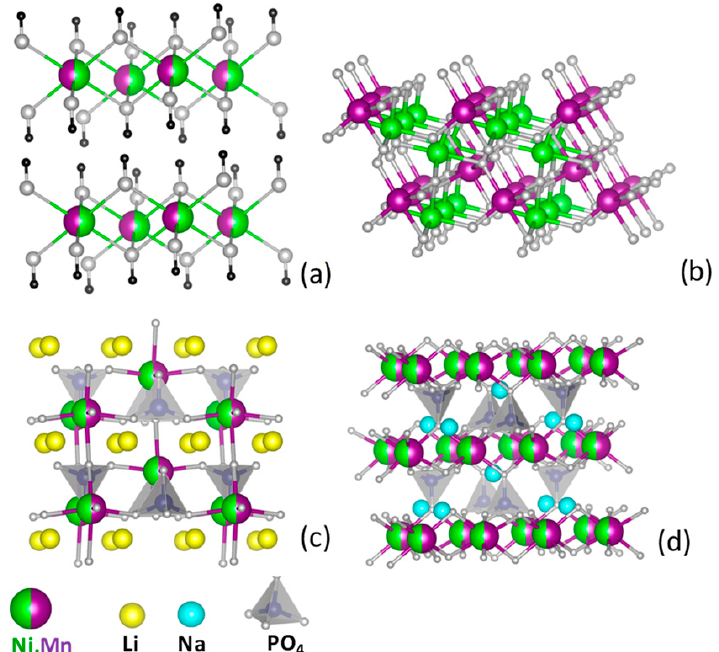
Figure 1. Schematic view of the crystal structures of mixed Ni–Mn phases: ( a ) β -Ni 1/2 Mn 1/2 (OH) 2 ; ( b ) NiMnO 3 ; ( c ) LiNi 1/2 Mn 1/2 PO 4 ; and ( d ) NaNi 1/2 Mn 1/2 PO 4 . The structures are adopted from: β -Ni(OH) 2 (COD 9011314), ilmenite (ICSD 31853), phospho-olivine (COD 4002560) and maricite (COD 1530437).